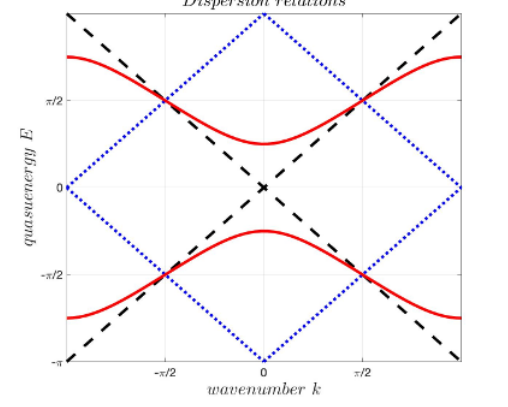
Fig. 2. (Color online)Dispersion relation of one-dimensional quantum walk. The continuous line shows a typical gap phase, where (slash) and (point). In both cases, the gap at h y = ± 𝜋𝜋 /4,h x = − k ε ± π h y = 0